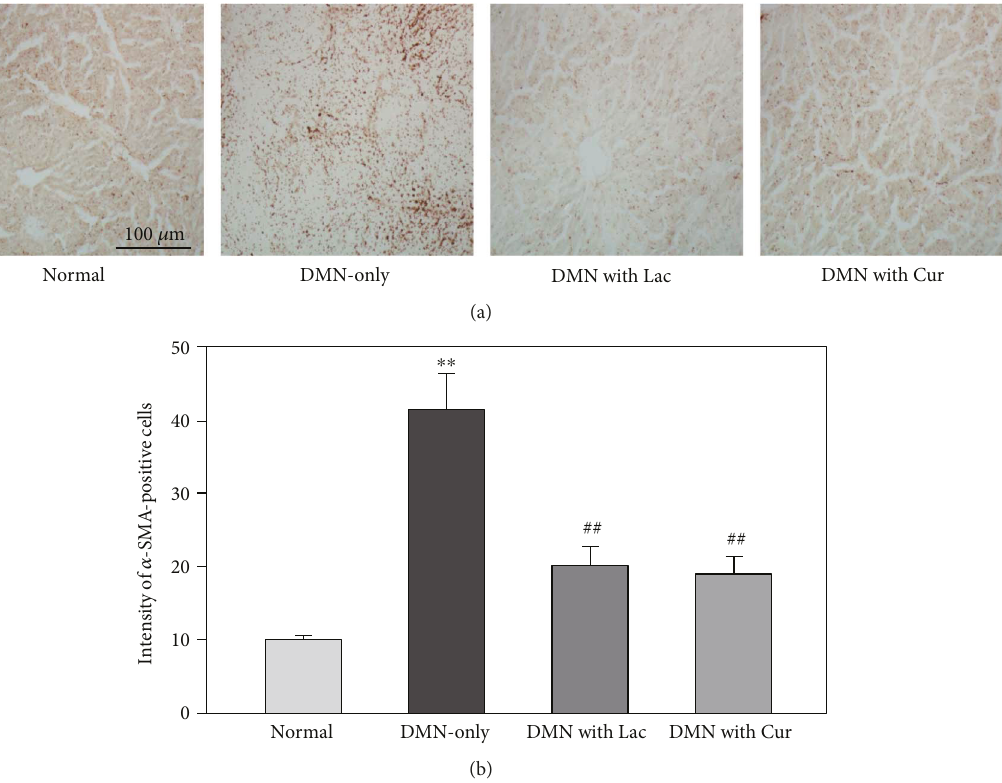
Figure 5: E ff ect of curcumin on α -SMA expression in liver tissue. (a) Representative photographs showing immunostained α -SMA in rat liver. (b) Positive cell count showing expression of α -SMA in rat liver tissue. Data are represented by mean ± SEM ( n = 6 in each group). Statistical signi fi cances are compared between the normal and DMN-only groups ( ∗∗ p < 0 01 ) or between the DMN-only and DMN with treatment groups ( ## p < 0 01